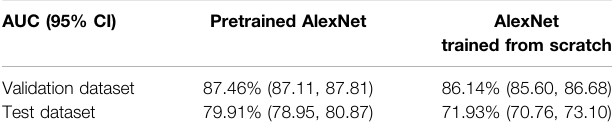
TABLE 2 | AUC results of AlexNet trained from scratch and fi ne-tuned from the pretrained model. AUC (95% CI) Pretrained AlexNet AlexNet